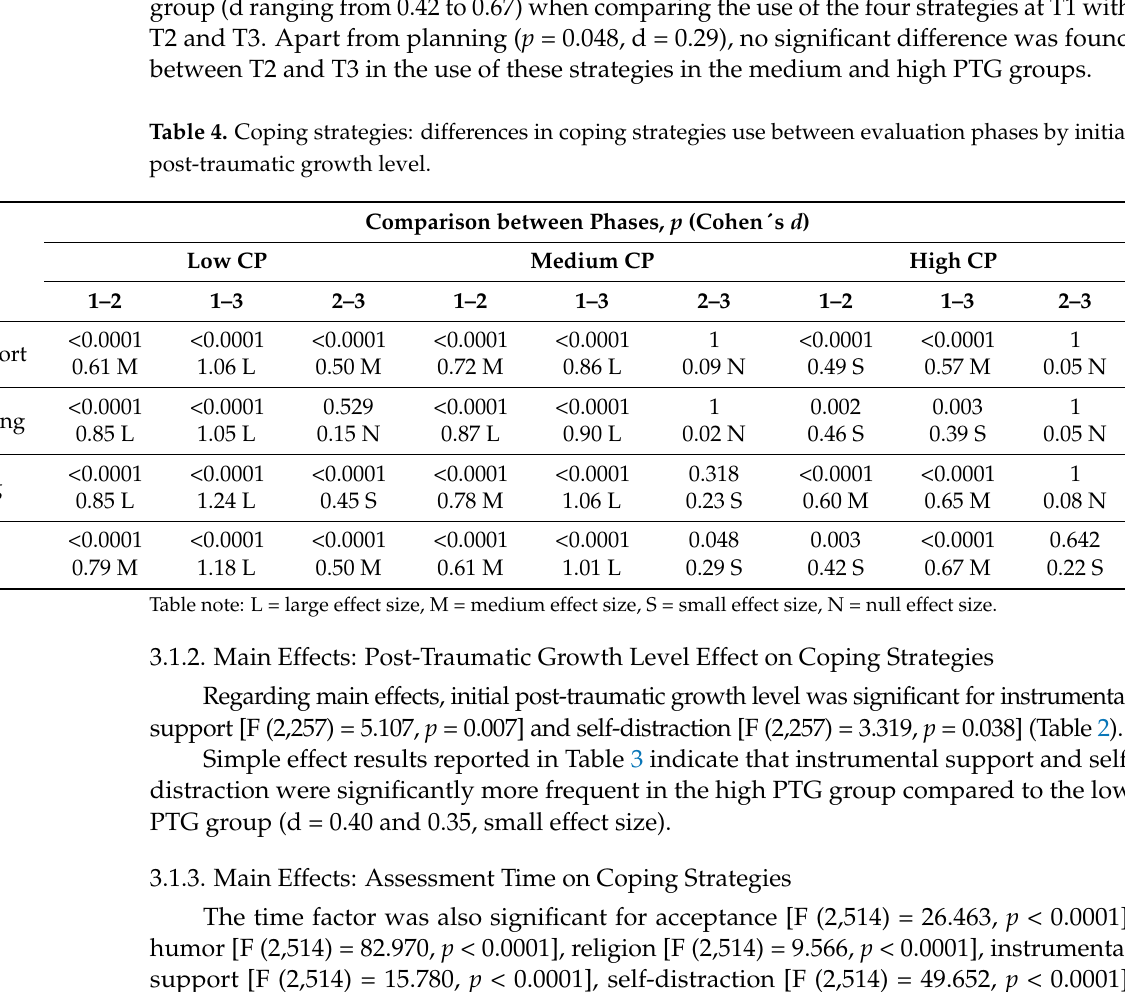
Table 4. Coping strategies: differences in coping strategies use between evaluation phases by initial post-traumatic growth level.